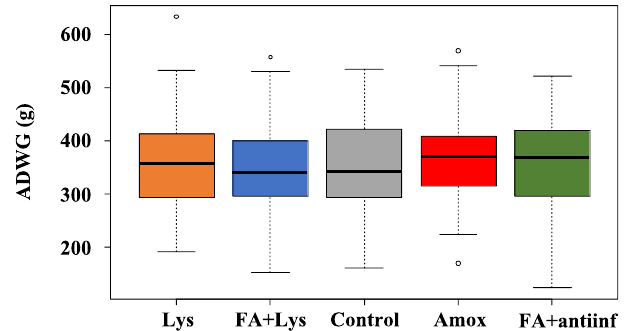
Figure 1. Average daily weight gain (ADWG) of piglets fed with different additives. Each boxplot corresponds to one treatment group: Lys lysozyme, FA + lys medium chain fatty acids and lysozyme, C control, with no additives, Amox amoxicillin, FA + antiinf medium chain fatty acids and a natural antiinflammatory. Dotted lines represent the standard deviation and outliers are indicated with white